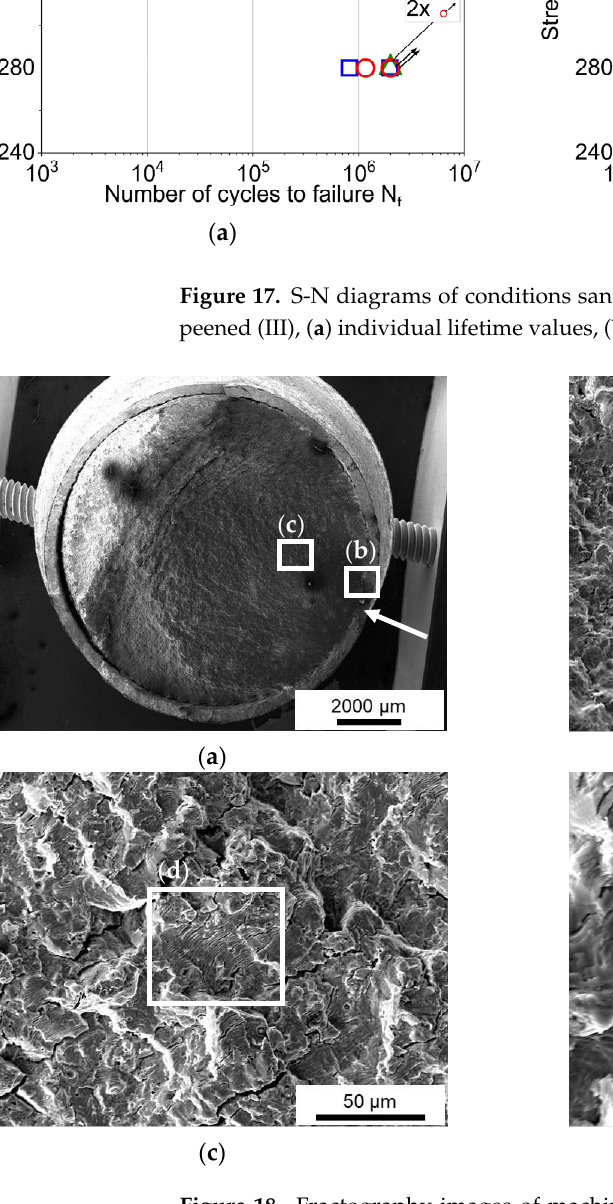
Figure 18. Fractography images of machine hammer-peened (III) specimen loaded at 320 MPa, ( a ) overview, ( b ) crack initiation from edge, ( c ) fatigue fracture area, ( d ) fatigue striations.